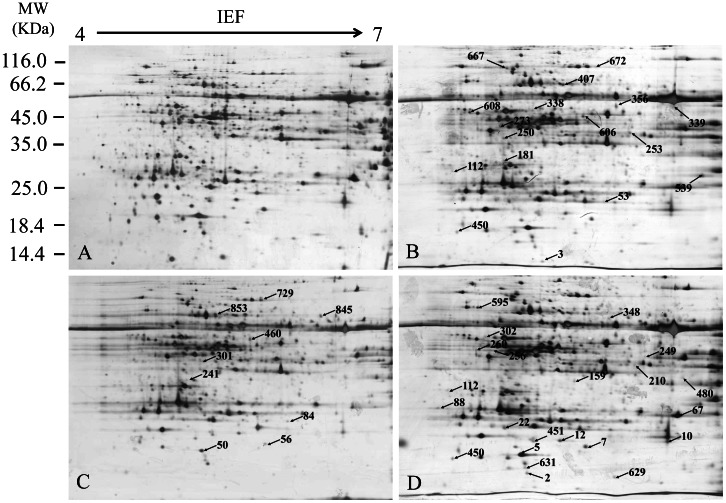
Representative 2-DE images of proteins extracted from S. salsa leaves.Proteins were submitted to isoelectric focusing on 4–7 IPG strips (24 cm) followed by electrophoresis on 10% SDS-PAGE. Gels were stained by silver stain. Gels are from the exposed groups of control (A), Hg2+ (20 µg L−1) (B), salinity (NaCl, 500 mM) (C) and Hg2++salinity (D).